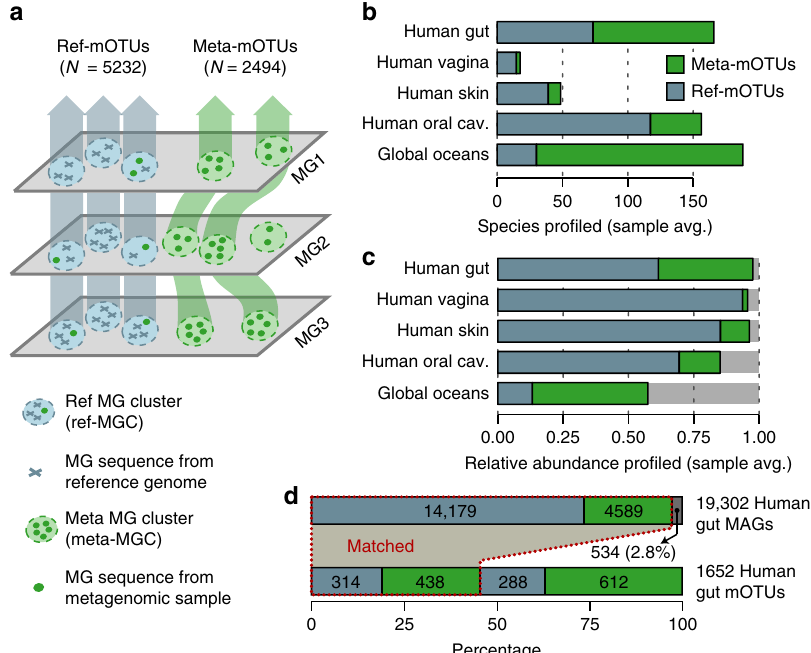
Fig. 1 Construction of marker gene-based OTUs (mOTUs) for metagenomic pro fi ling. a Schematic illustration of the mOTUs concept (Methods). b The observed richness of ref-mOTUs (containing exclusively MG sequences from reference genomes; blue) and meta-mOTUs (containing only MG sequences from metagenomes; green) per biome, and c mean cumulative relative abundance of species pro fi led across 2481 metagenomic samples. d Correspondence between mOTUs and 19,302 metagenome assembled genomes (MAGs) from the human gut. While less than 3% of MAGs are not represented (dark grey bar), mOTUs allow for pro fi ling of 900 species not captured by MAGs. Source data are provided as a Source Data fi